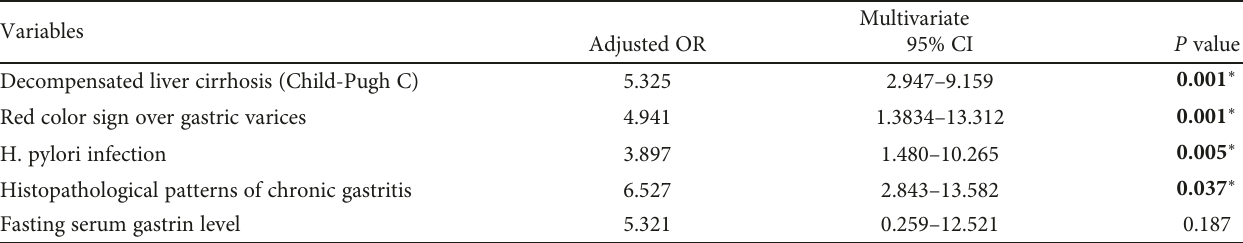
Table 4: Multivariate analysis of predictors of bleeding gastric varices among the studied